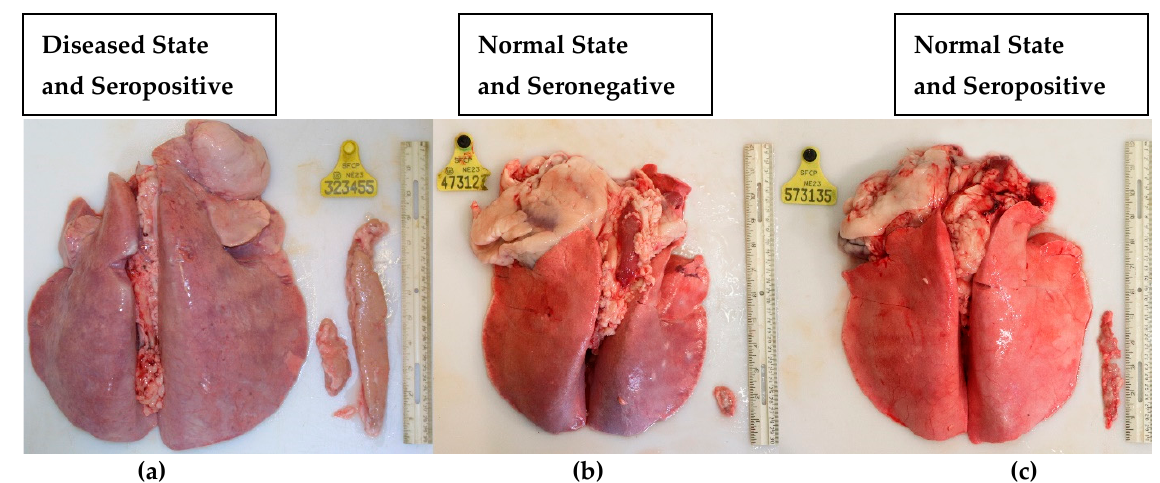
Figure 3. Comparison of representative tissues from a seropositive OPPV infected sheep with that of two “4,4” diplotype ewes one seronegative and one seropositive for OPPV. ( a ) Lungs and mediastinal lymph nodes of a seropositive sheep with lesions typical for OPP. The lungs are mottled grey and the mediastinal lymph nodes are greatly enlarged. Histopathology indicated hallmark severe lymphoproliferative inflammation. ( b ) Tissues from a 6-year-old “4,4” TMEM154 diplotype ewe that was serologically negative for OPPV at the end of the evaluation experiment. Both lung and mediastinal lymph tissues were normal in size and appearance by digital palpation. The mild red discoloration of the caudodorsal aspects of the lungs is caused by how they were positioned post-mortem. Any discoloration would be best described as dependent passive hemostatic congestion. ( c ) Tissues from a 5-year-old “4,4” TMEM154 diplotype ewe that was serologically positive for OPPV by 17 months of age. At the time of tissue collection, this ewe had been serologically positive for a minimum of 40 months. Both lung and mediastinal lymph tissues were normal in appearance and by digital palpation.